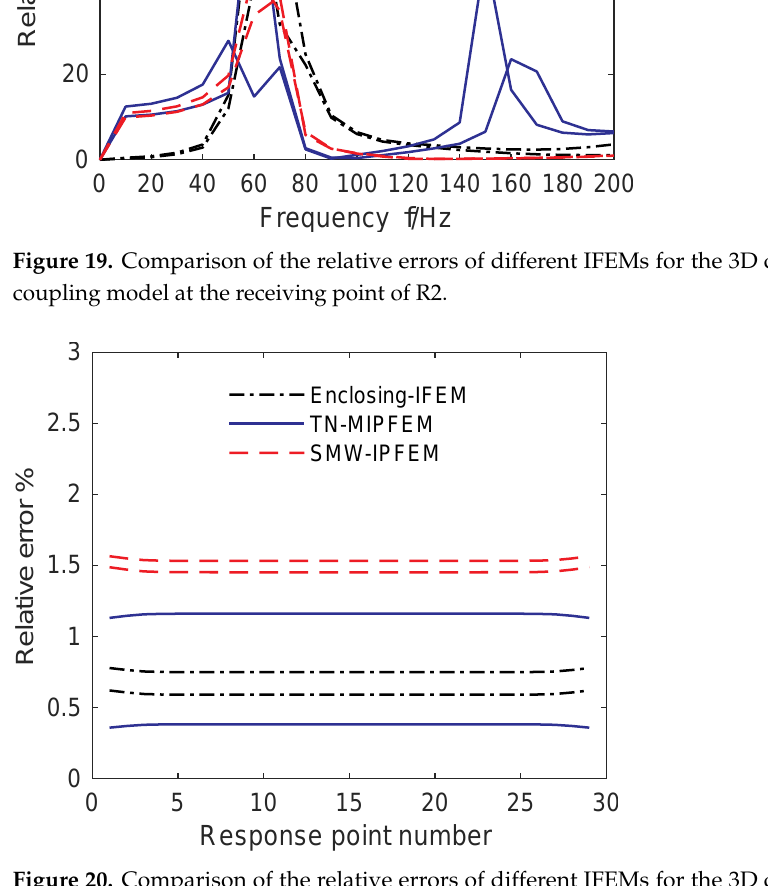
Figure 20. Comparison of the relative errors of different IFEMs for the 3D classical vibro-acoustic coupling model along the midface line at frequency 100